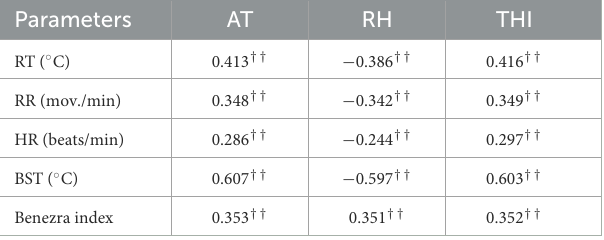
TABLE 4 Correlation between the physiological variables of horses and the adaptability index with climate variables in Ananindeua, Pará. Parameters AT RH